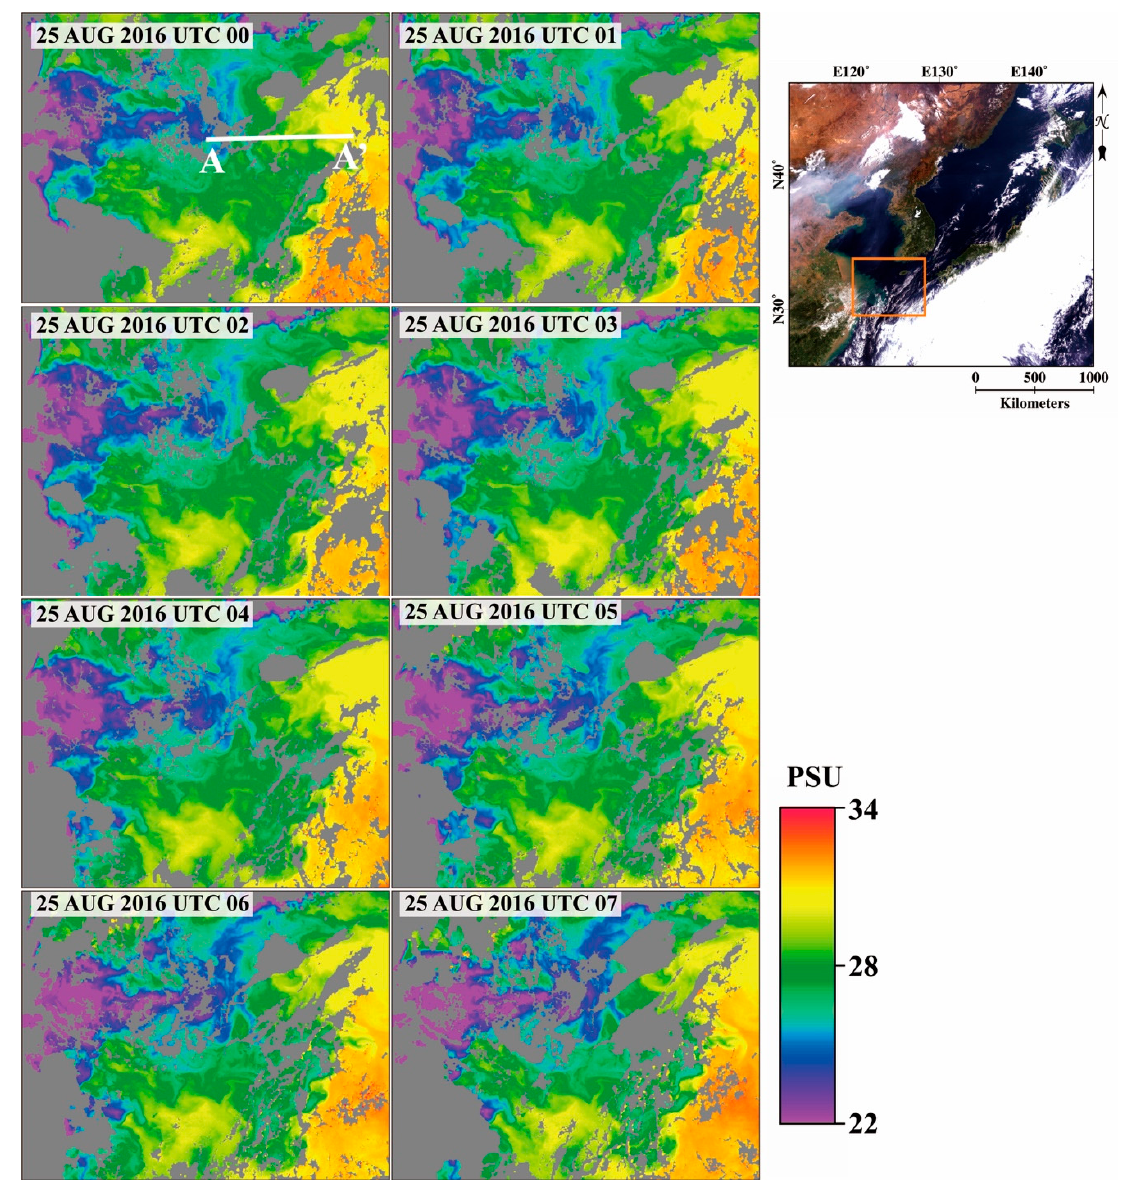
Figure 4. The GOCI-derived SSS images from 09:30 (UTC 00) to 16:30 (UTC 07) on 25 August 2016 generated in this study, with the SSS profile line (AA') also shown.